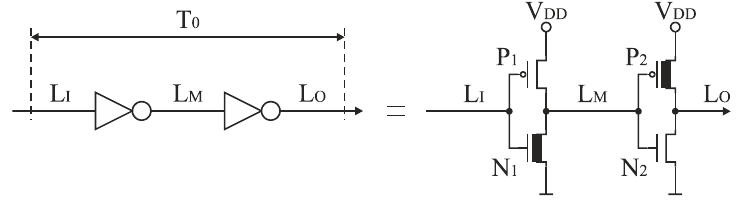
Figure 24. Asymmetric design of pair of inverters.